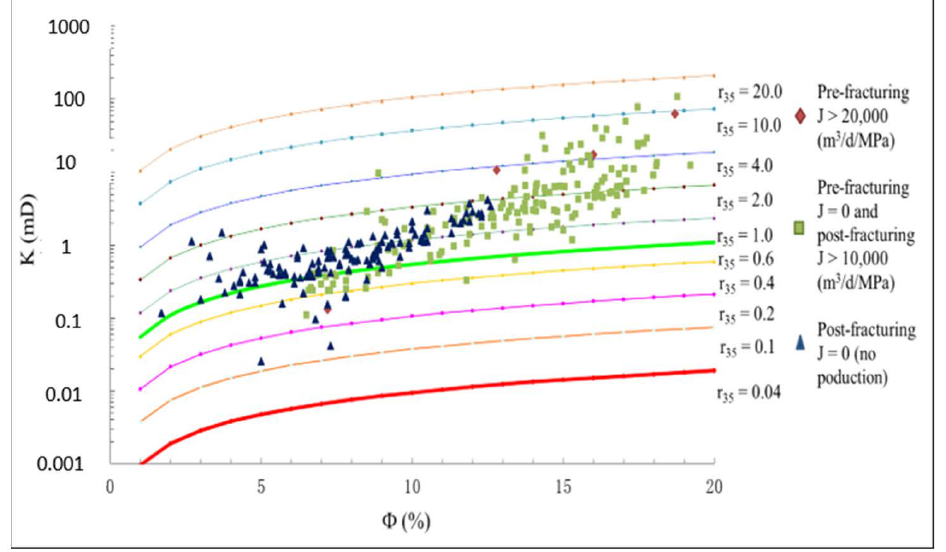
Figure 8. Porosity-permeability crossplot under various r 35 values of the Y